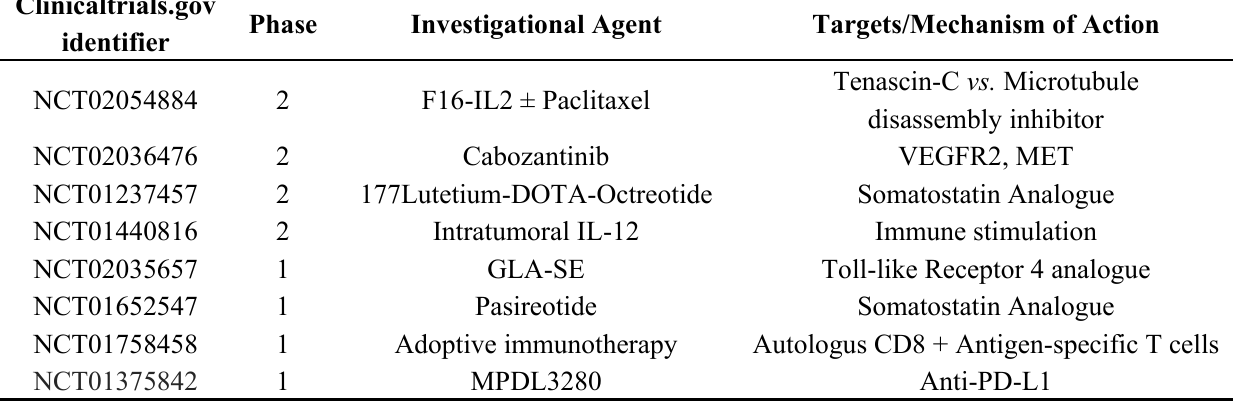
Table 1. Clinical trials currently recruiting MCC